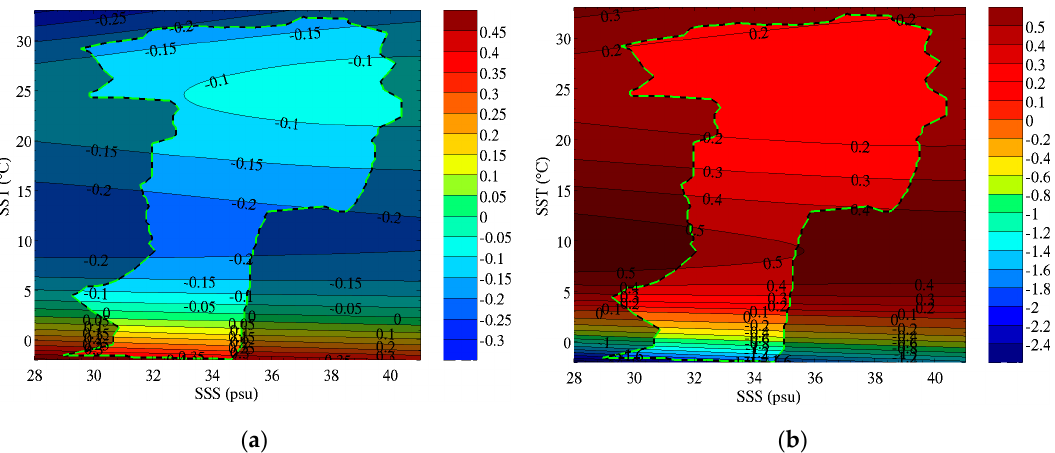
Figure 4. Differences in TB and SSS due to differences between the dielectric constant model by Klein and Swift [39] and Meissner and Wentz [41]. ( a ) Differences in brightness temperature at L ‐ band for a flat surface and an incidence angle of 38° (similar to Aquarius middle beam). ( b ) Differences in retrieved SSS when assuming KS the truth (i.e., used to compute TB from assumed SST 0 and SSS 0 ) and using MW for retrieving SSS from TB and the same SST 0 . The shaded area reports unlikely combinations of SSS and SST (i.e., less than 5 Argo records over the last period 2000–2018). The differences in TB are between − 0.25 K and +0.40 K with the KS model predicting TB smaller than MW at most SST (>4 °C) and SSS. The horizontal stratification of the contours in Figure 4 shows that the difference is mostly a function of SST (reported on the y ‐ axis) and varies much less with SSS (reported on the x ‐ axis). For the most common oceanic conditions (33.75 psu < SSS < 35.75 psu), TB from the KS model is ~0.1 K cooler than TB from MW in warm waters, and 0.2 K cooler in more